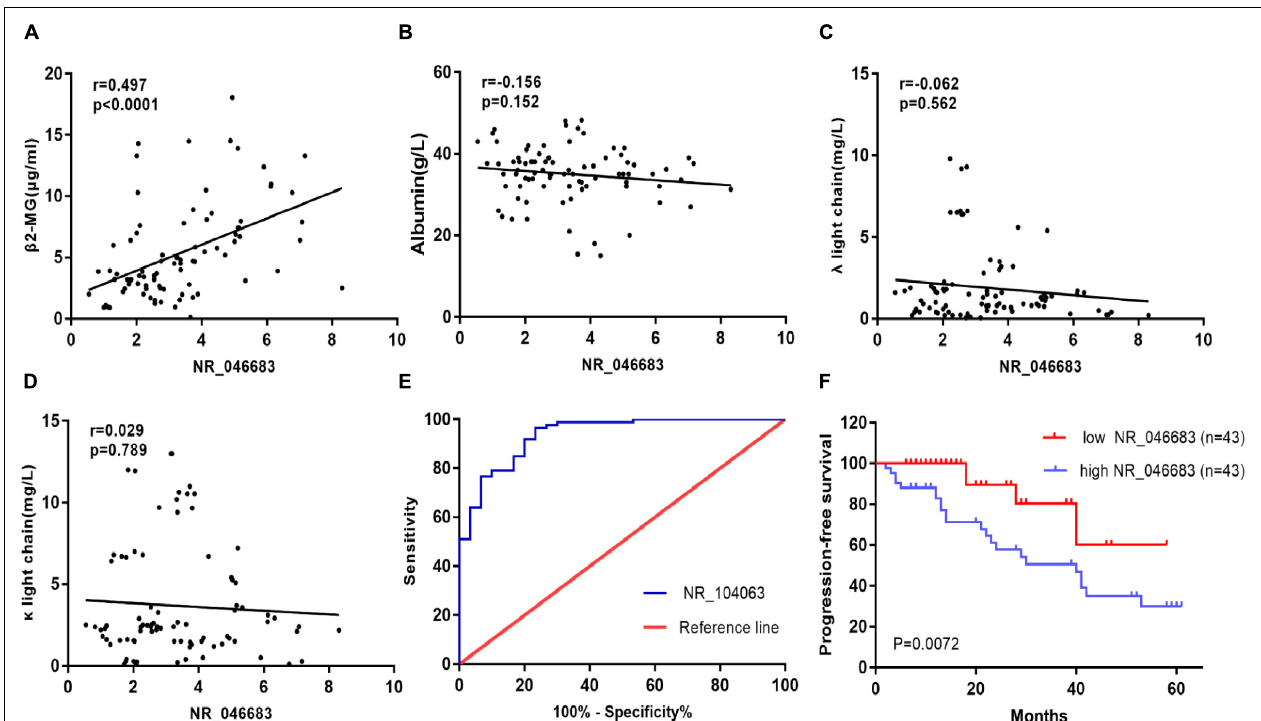
FIGURE 2 | Clinical significance of lncRNA expression in bone marrow of MM patients. (A) Correlation between lncRNA expression in bone marrow and serum β 2 M. (B) Correlation between lncRNA expression in bone marrow and serum albumin. (C) Correlation between lncRNA expression in bone marrow and serum λ light chain. (D) Correlation between lncRNA expression in bone marrow and serum κ light chain. (E) ROC curve for lncRNA NR_046683, and (F) Kaplan-Meier survival curve for low and high expression of lncRNA NR_046683 in MM patients. MM, multiple myeloma; ROC curve, receiver operating characteristic curve; β 2 -MG, β 2